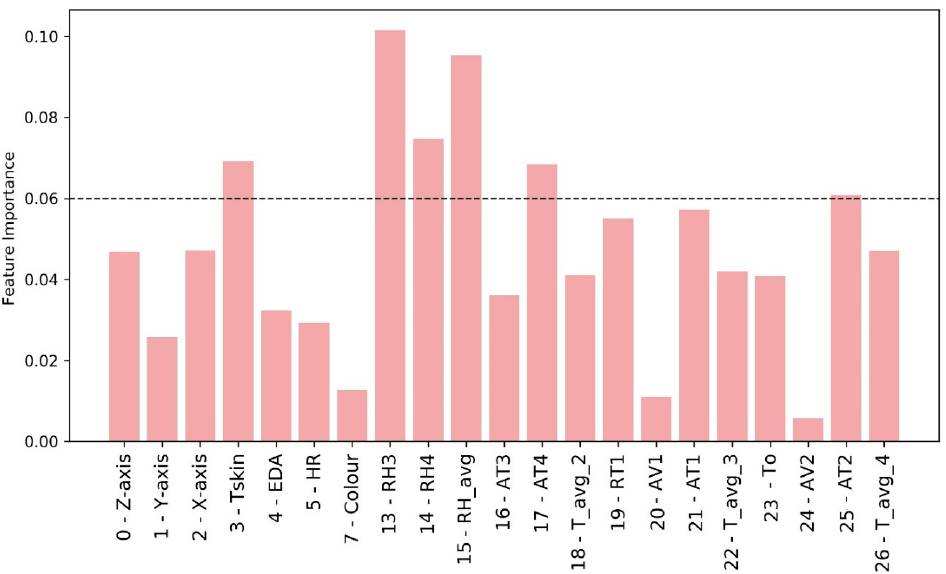
Figure 10. Relative feature importance of Extra Trees classifier using all the environmental and biometric data to define users in the VR scenario. Table 8. Recursive Feature Elimination for the VR scenario. The feature numbers are the same as those in Table 4, which are reported here for your convenience: 0 : Z-axis acceleration; 1 : Y-axis